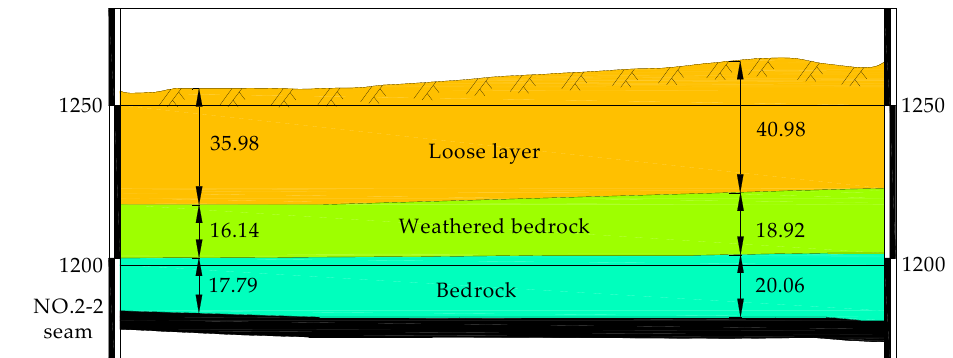
Figure 3. Sectional view of the setup entry of No. 22201 working face.